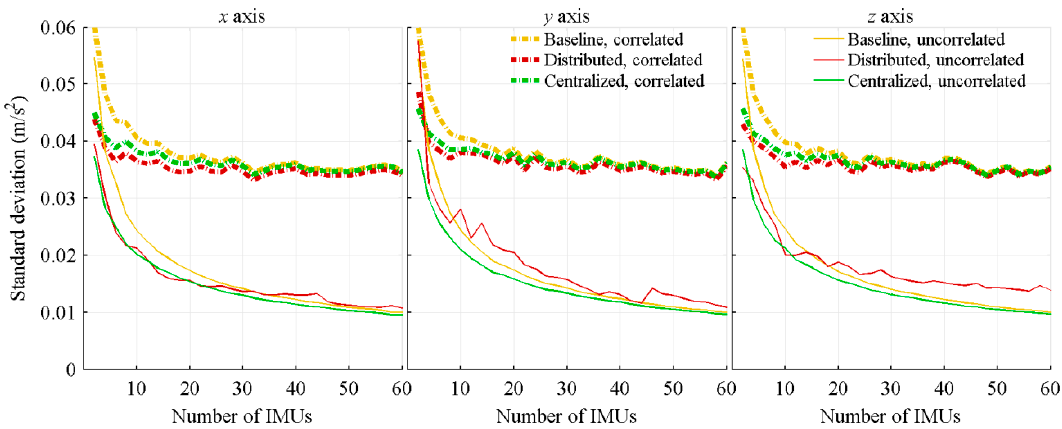
Figure 6. Standard deviation of the acceleration estimation errors, with correlated and uncorrelated sensors bias, and function of the number of IMUs. Sensors 2018 , 18 , x FOR PEER REVIEW